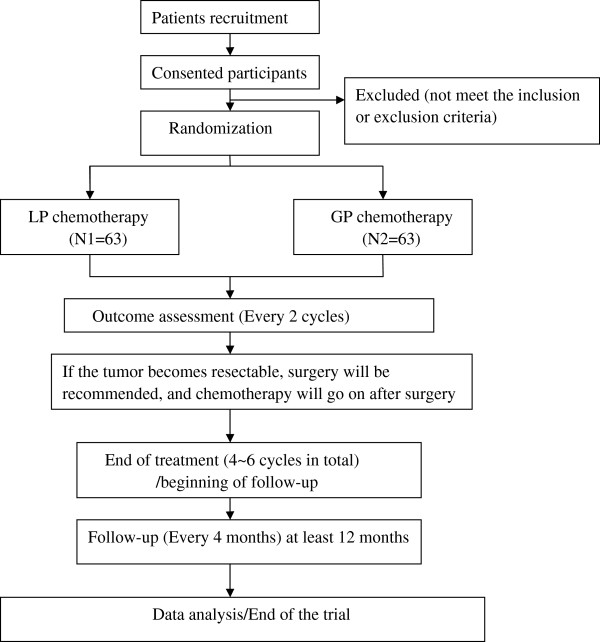
Study flow chart.